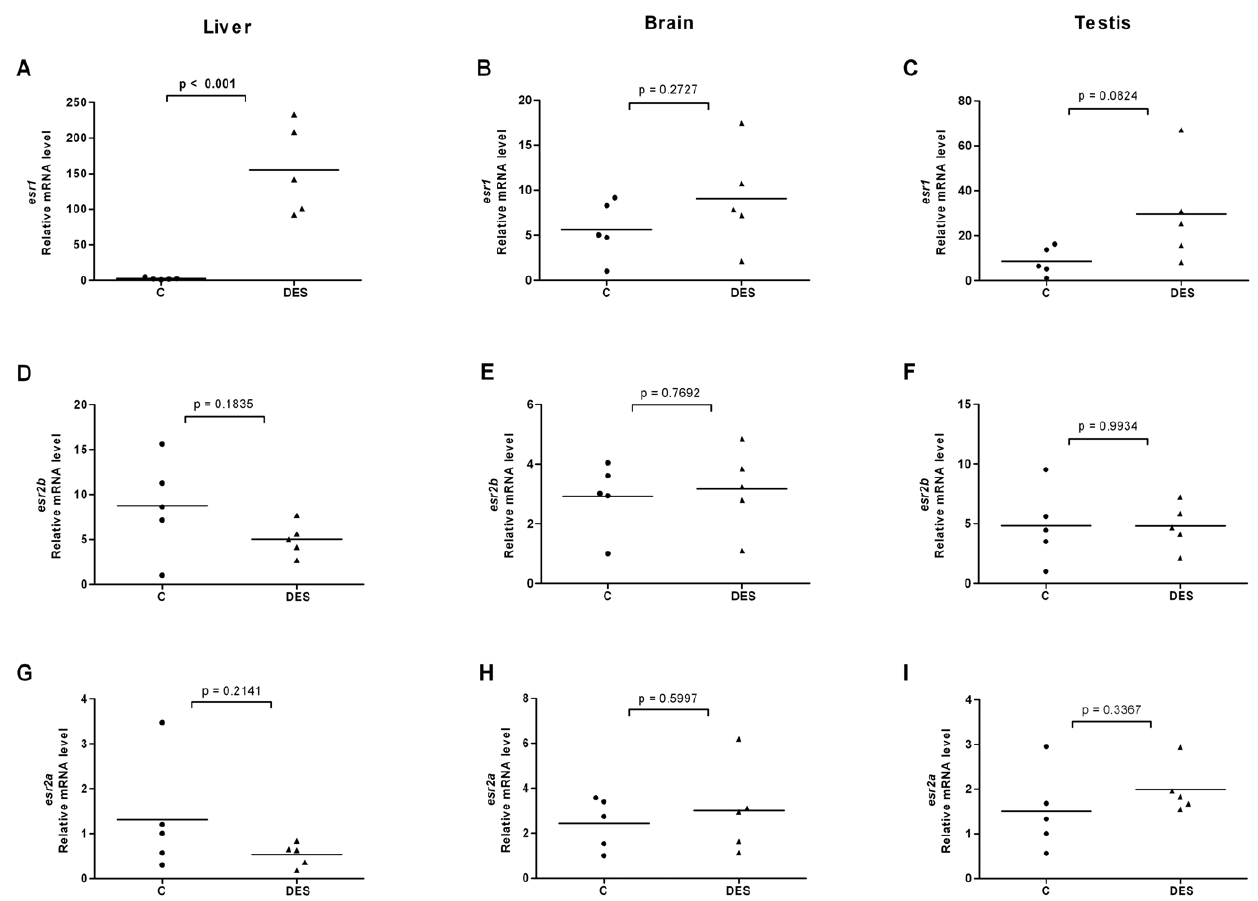
Figure 7. Effects of diethylstilbestrol on esr expression in liver, brain and testis of male fish. Expression levels of esr1 (A–C), esr2b (D–F) and esr2a (G–I) in liver, brain and testis of male fish following exposure to DES (1 m M).